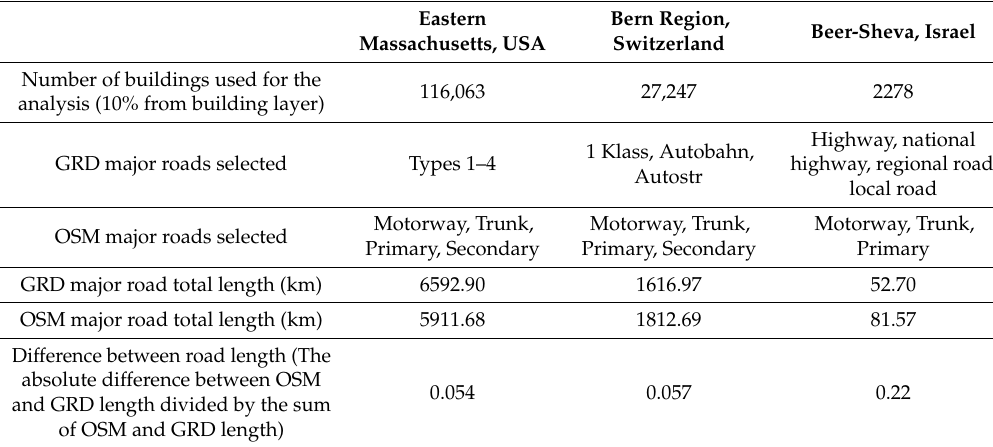
Table 5. Data used to calculate the exposure